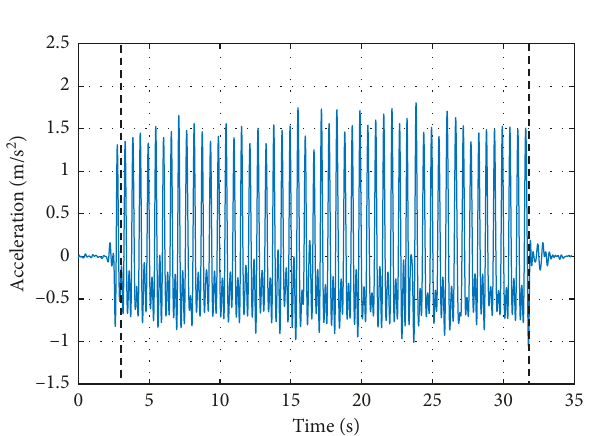
Figure 5: Clavicle acceleration of Participant No. 18 (solid) with cutting lines (dashed) bouncing at